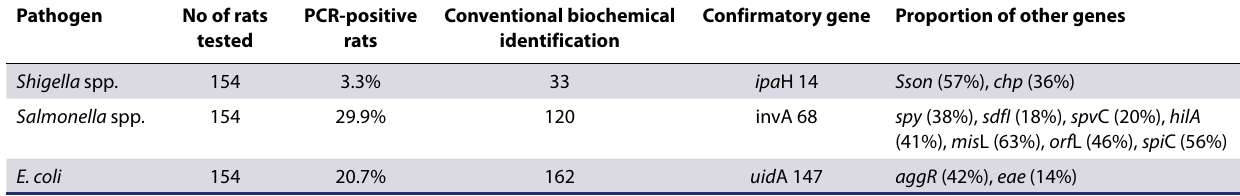
Table VI: The prevalence of the pathogens based on biochemical tests and DNA results and the proportions of detected genes Pathogen No of rats Conventional biochemical Confirmatory gene Proportion of other genes tested identification Shigella spp. Salmonella